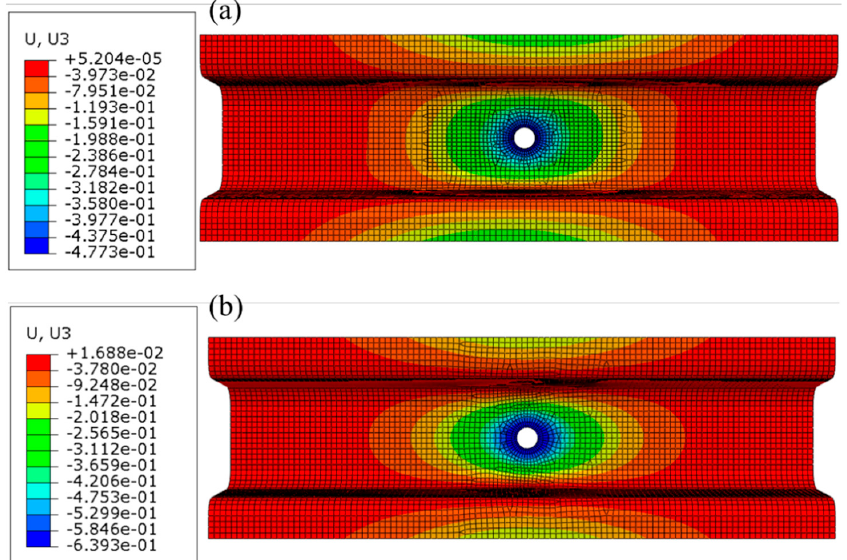
Figure 6. Deformation contour: ( a ) deformation of CFRP structure after postprocessing; ( b ) deformation of original steel structure.